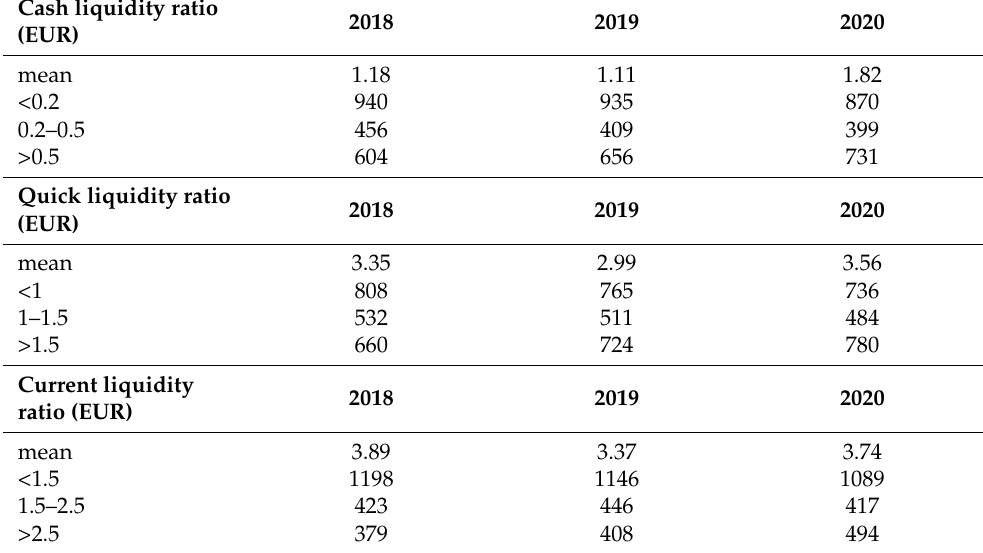
Table 4. Liquidity ratios of the enterprises operating in the construction sector during